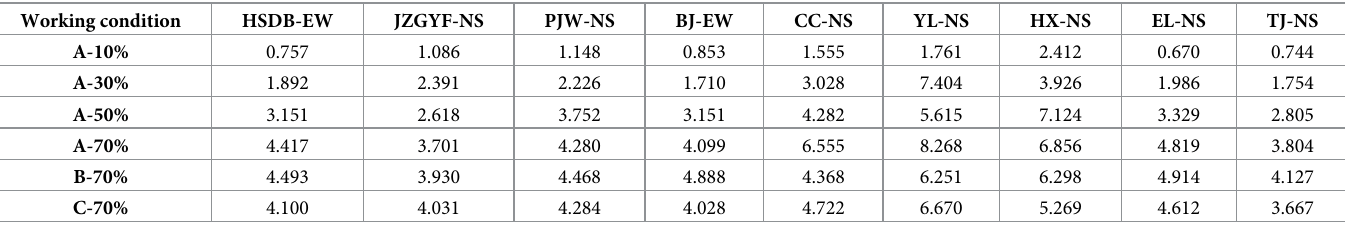
Table 13. The maximum hydrodynamic pressure P WD , x of the whole tank under unidirectional main seismic motion with 1.0 m/s 2 peak acceleration (KPa). Working